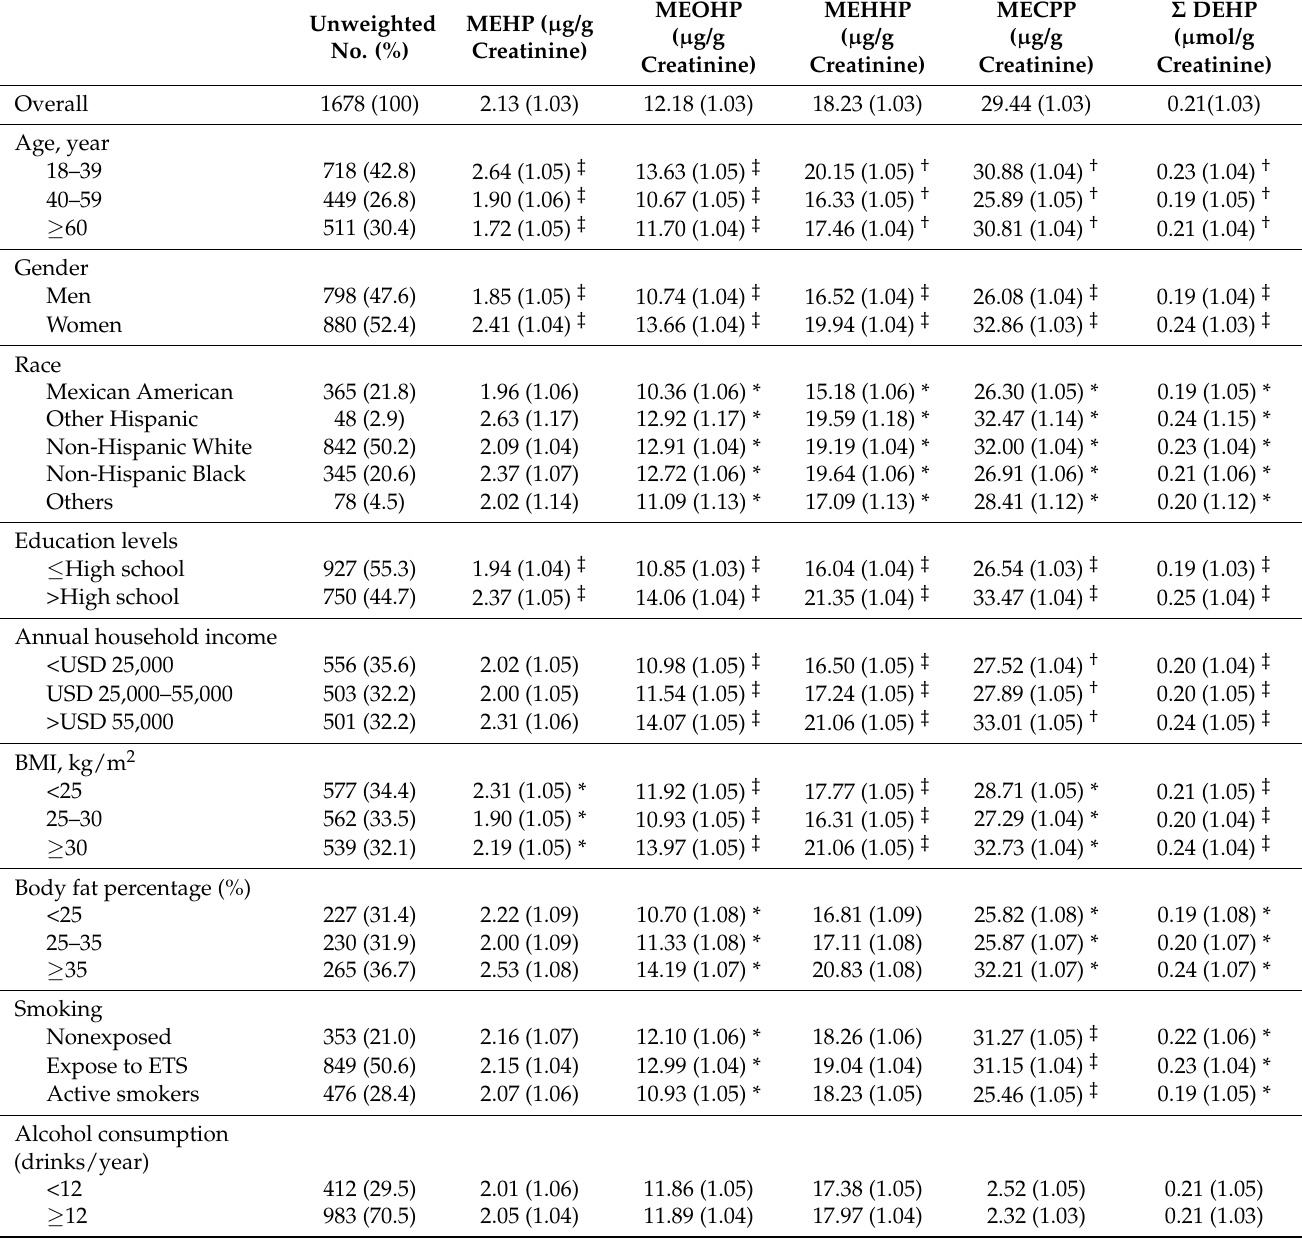
Table 1. Basic demographics of the sample subjects, including geometric means (geometric S.E.) of DEHP metabolites